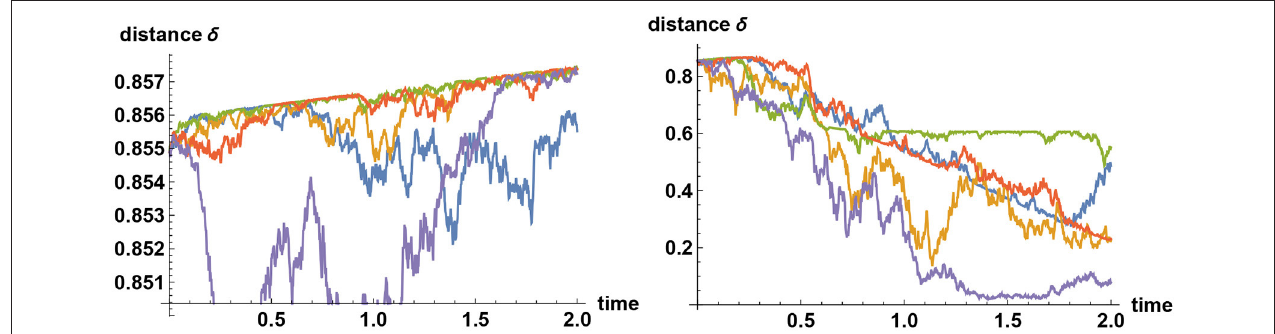
FIGURE 4 | Separation distance under Bayesian updating. The polarity, or distance δ of two decision makers, when they are provided with an identical set of noisy information, has a tendency to increase under the Bayesian updating, even though on average it decreases in time. Five sample paths are shown here for two different choices of σ . On the left panel the information flow rate (signal to noise ratio) is taken to be σ 0.2. Simulation studies (not shown here) indicate that in this case the = upward trend persists for some 40 years in about 50% of the sample paths, and the separation distance is typically reduced to half of the initial value after about 100 years. When the information flow rate is increased eleven-fold to σ 2.2, polarized Bayesian learners are forced to converge a lot quicker, as shown on the right = panel, where the separation is reduced to half of its initial value typically within 2